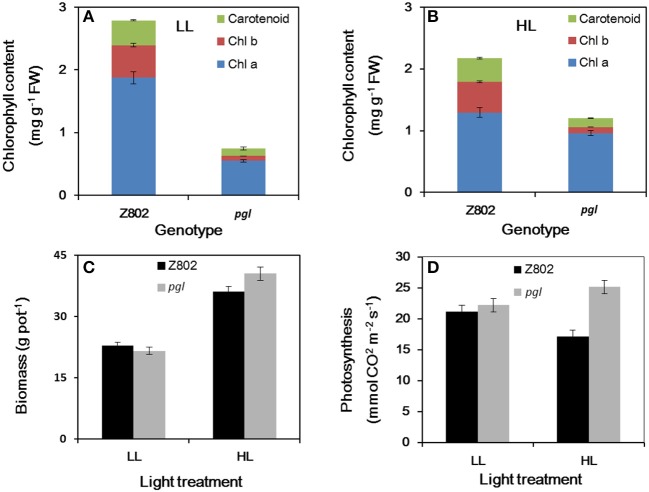
Chlorophyll content (A,B), biomass (C), light-saturated photosynthesis (D) for Z802 and pgl from high (HL) and low light (LL) adapted plants. Data represent the means of three replicates per treatment ± standard deviation. The photosynthesis was measured at light intensity of 1,500 μmol m−2 s−1, temperature of 25°C with Li-6400.